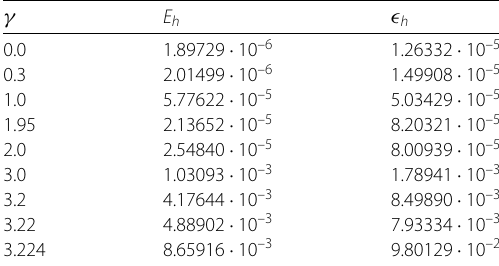
Table 1 The errors for different γ in the case of h = 0.01 γ E h (cid:10) h